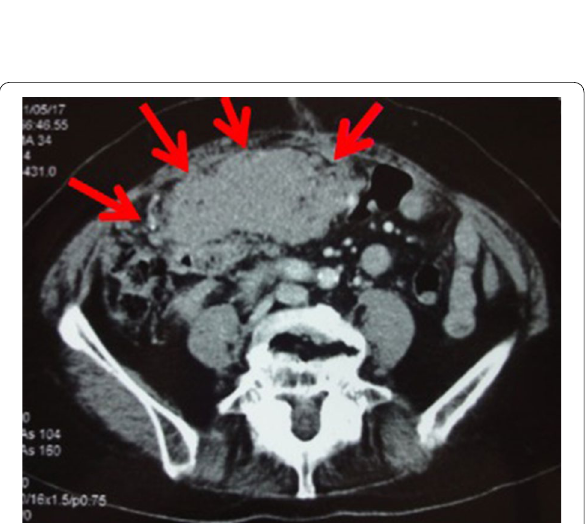
Fig. 2 Preoperative findings by abdominal CT scan. A tumor about the size of one’s palm was observed in the duodenum and the head of pancreas. The tumor was compressing the duodenum, causing loss of appetite and detention. Arrows ( ) show the tumor’s margin → occupying the abdominal